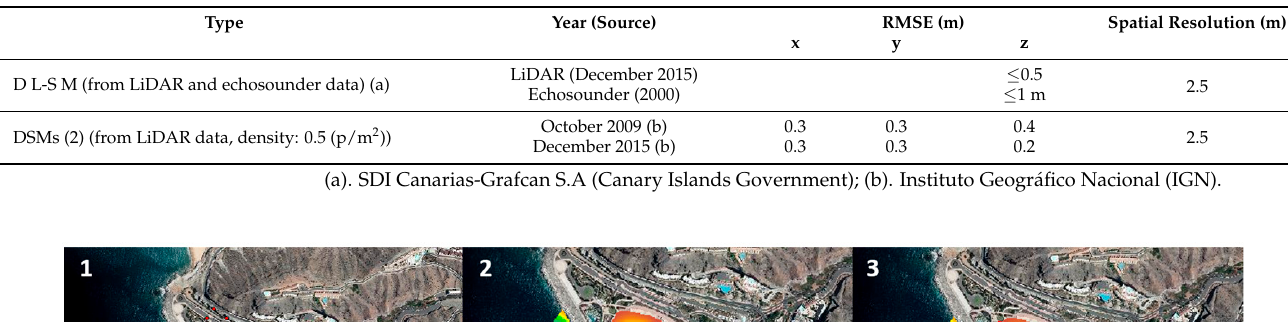
Table 1. Digital surface models (DSMs) used in this research.